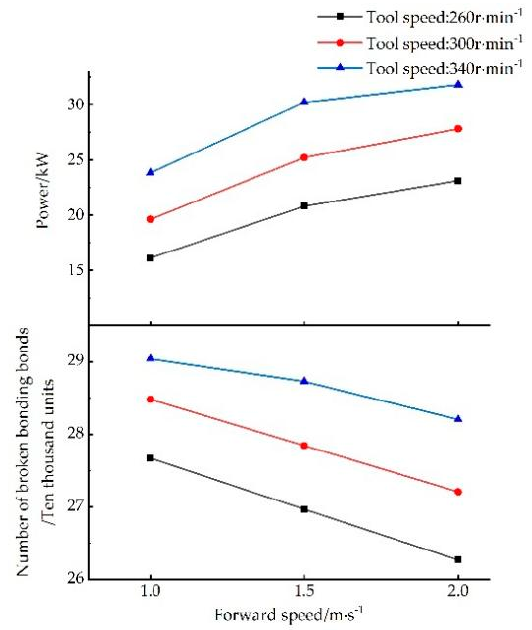
Figure 14. Influence of operational parameters on test